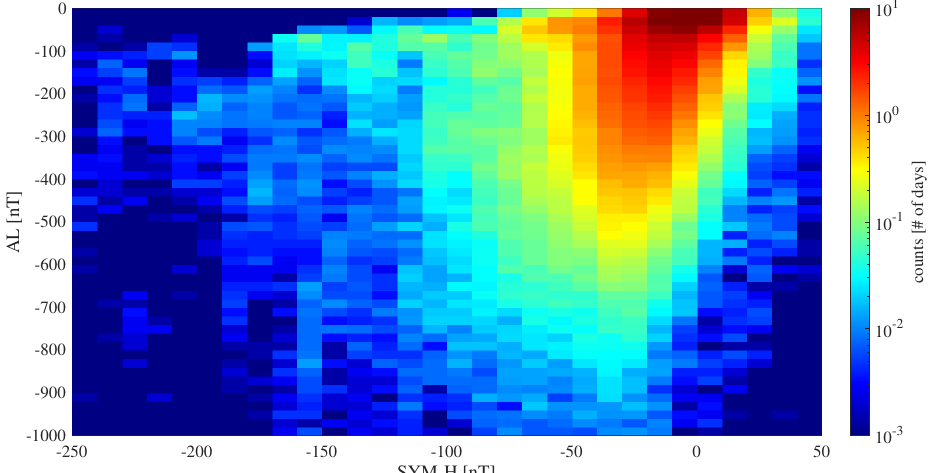
Figure 2. Joint probability density (frequencies of occurrences) of values of the SYM-H and AL geomagnetic